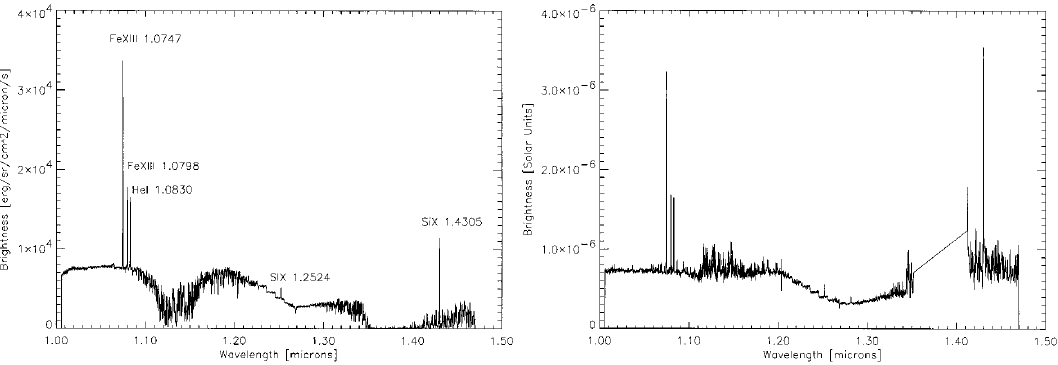
Figure 18: The coronal spectrum from 1000 to 1500 nm of the 1994 eclipse. The left panel shows the raw counts, and the right panel is normalized to the disk center solar intensity. Lines are seen at 1075, 1080, 1083, 1251, and 1431 nm. Image reproduced with permission from Kuhn et al. (1996), copyright by